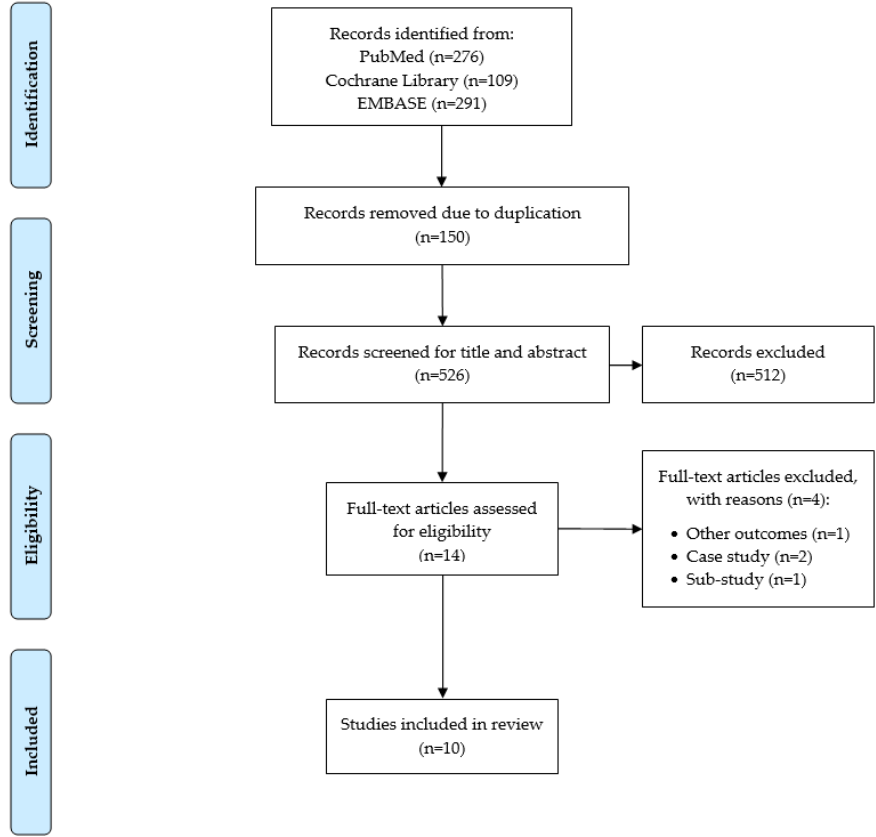
Figure 1. PRISMA consort diagram for paper selection.